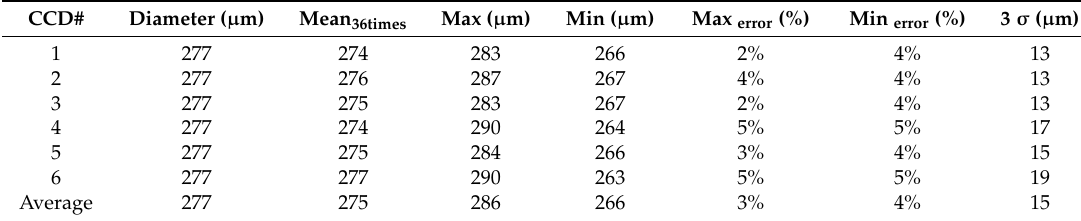
Table 3. Results for Detected Protrusion on Red Film.